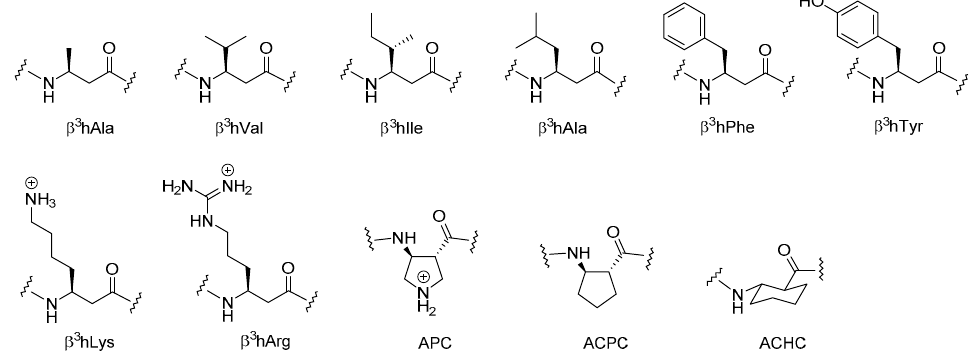
Figure 12. Typical β 3 -amino acid residues in designed antibacterial and antifungal β 3 -peptides.